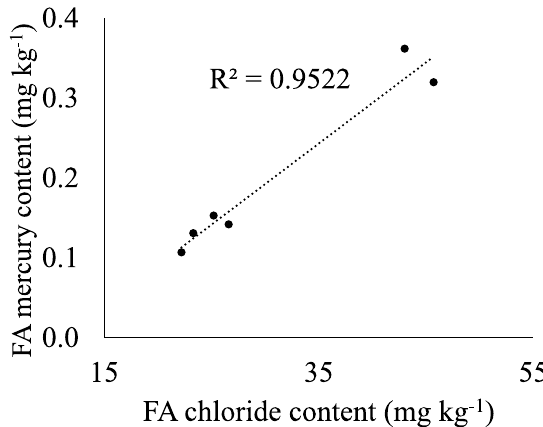
Fig. 3 Correlation of Hg in fly ash with chloride content in FA